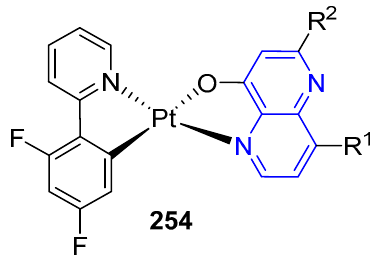
Figure 36. Platinum complexes as